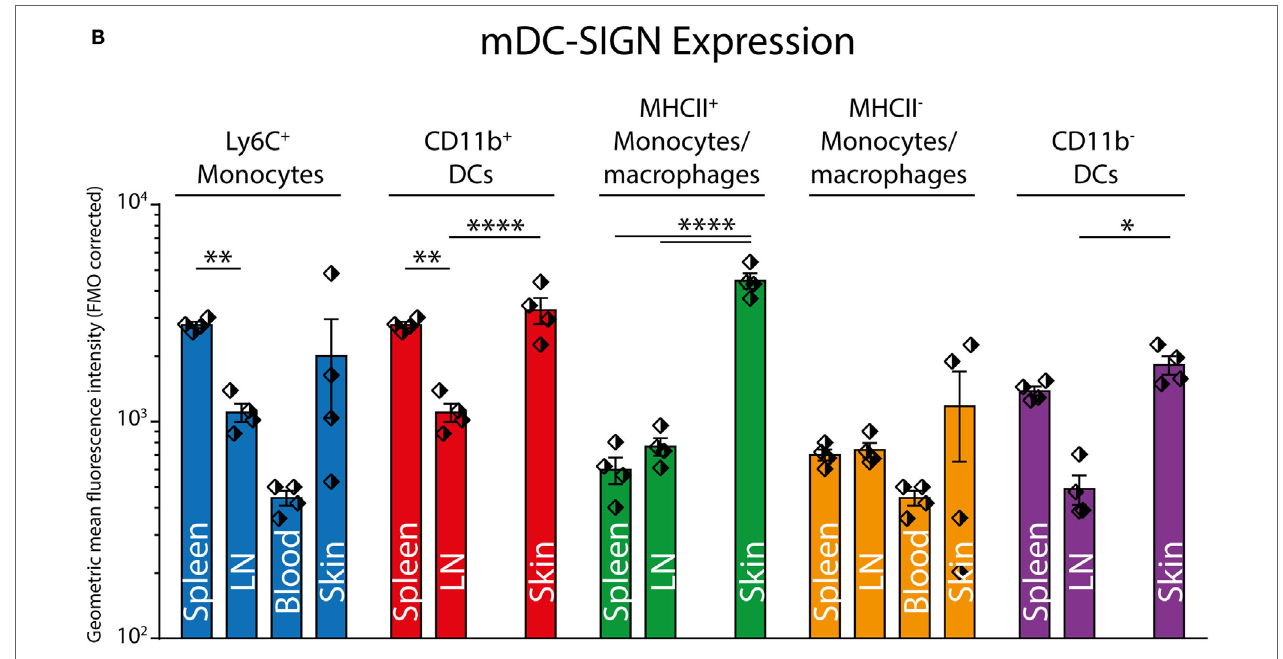
FigUre 4 | Unsupervised clustering (tSNE) of total CD45 + cells distinguishes organ-specific immune cell subsets expressing mDC-SIGN. (a) Unsupervised clustering (tSNE) of alive single CD45 + cells based on high-dimensional flow cytometry into two dimensions allows the distinction of immune subsets and reconstruction of cell frequency (density plot) within the immune composition. Expression of mDC-SIGN (blue histogram) is generally expressed by monocytes/macrophages in the skin and spleen. Dendritic cells in the spleen express clear levels of mDC-SIGN, but expression is less pronounced in the skin-draining lymph nodes (LNs). (B) mDC-SIGN is highly expressed on myeloid cells and in particular monocytes/macrophages and DCs in the skin. Also, expression is high on CD11b − and CD11b + DCs in the spleen, compared to the LN. Data in the bar graphs represented as mean ± SEM ( N = 4, representative of two individual